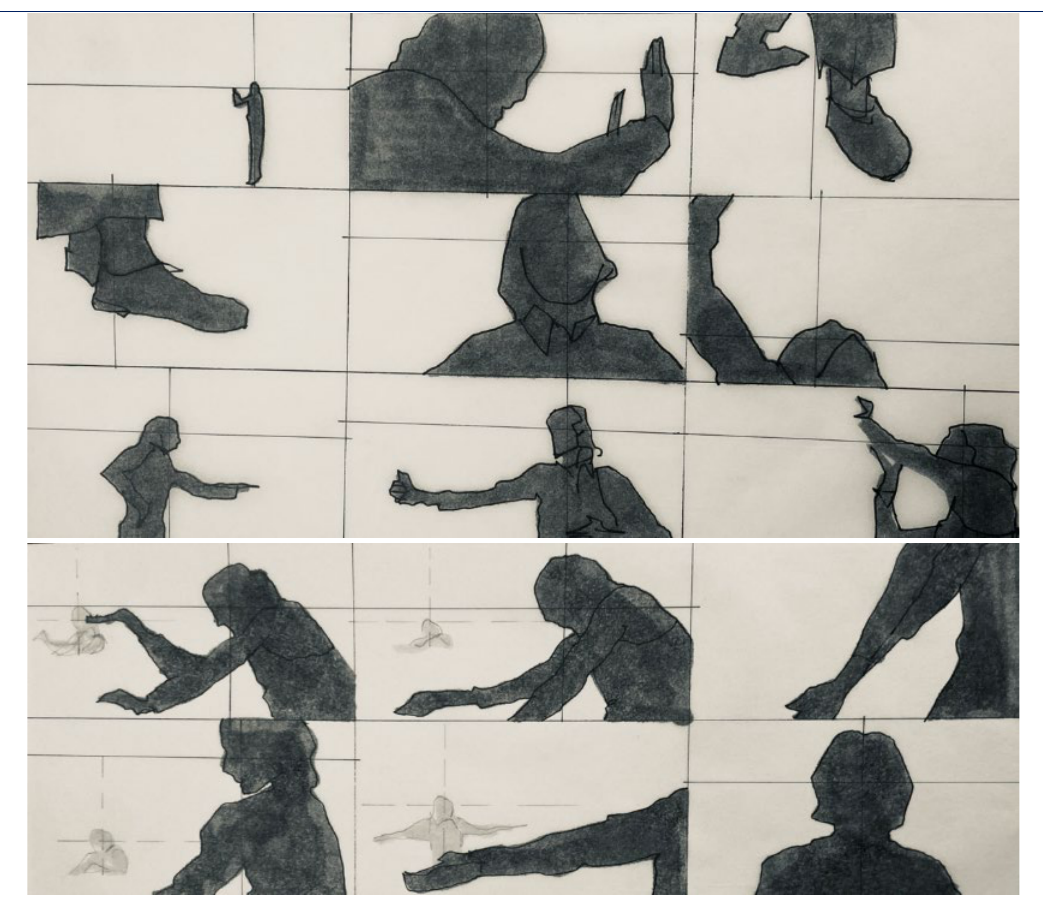
Figures 32-33 Analysis of Metamorphosis scene showing Arthur’s reinvention of the space through the movement of his body within